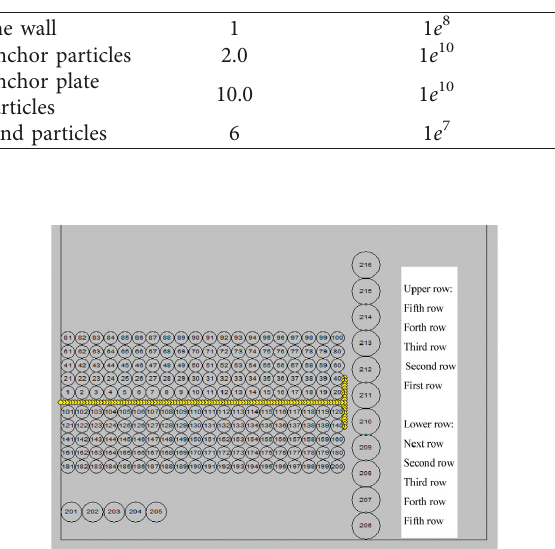
Figure 11: Measuring circle arrangement diagram.